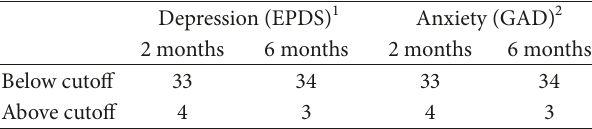
Table 3: Frequencies of depression and anxiety at 2 and 6